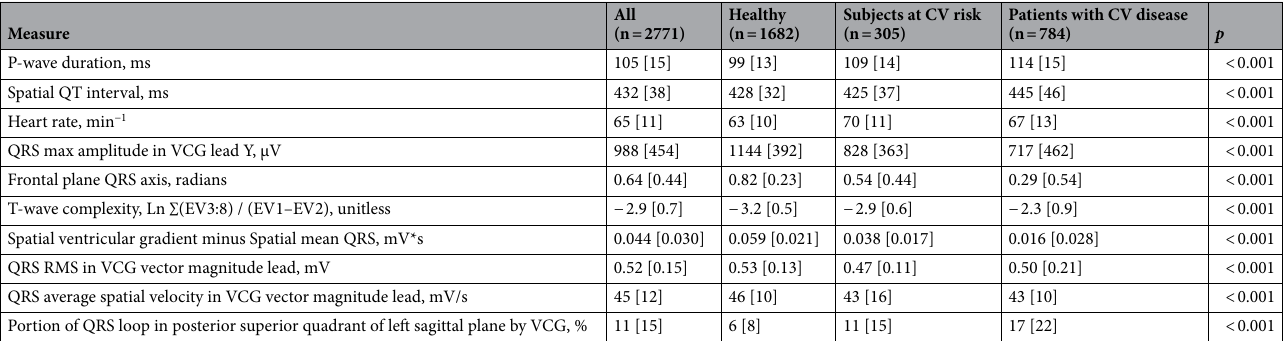
Table 2. ECG measures in all patients, stratified by health, cardiovascular risk or cardiovascular disease. All values are presented as mean (SD). CV: cardiovascular; Ln: Natural logarithm; EV: Eigenvalues; VCG: vectocardiographic; RMS: root mean